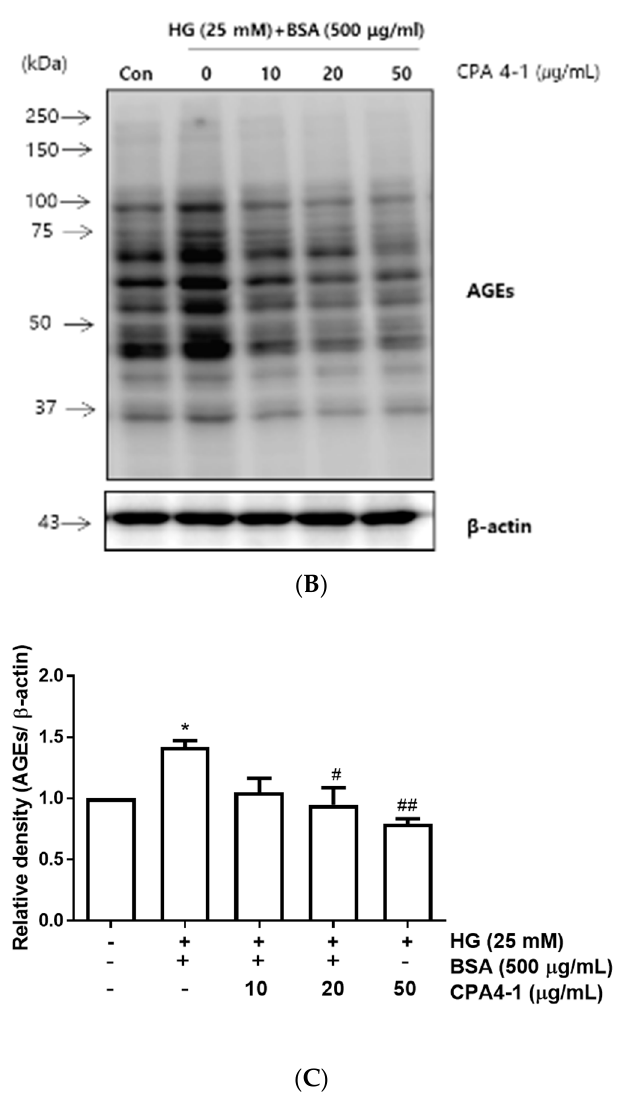
Figure 2. Inhibitory effect of CPA4-1 on the formation of advanced glycation end product (AGE). ( A ) AGE-fluorescence. *** p < 0.001 vs. Con; ## p < 0.01, ### p < 0.001 vs. AGE (N = 8). ( B , C ) Inhibitory effect of CPA4-1 on AGE formation in ARPE-19 cells. Data are expressed as mean ± SD. * p < 0.05 vs. Con; ## p < 0.01, # p < 0.05 vs. High glucose (HG) + BSA (n = 4).